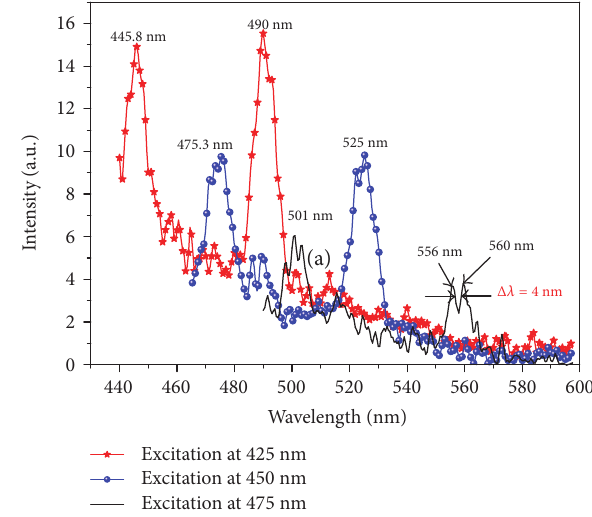
Figure 6: Raman spectra of acetone at di ff erent slit widths. (a) Blue line and (b) black line.